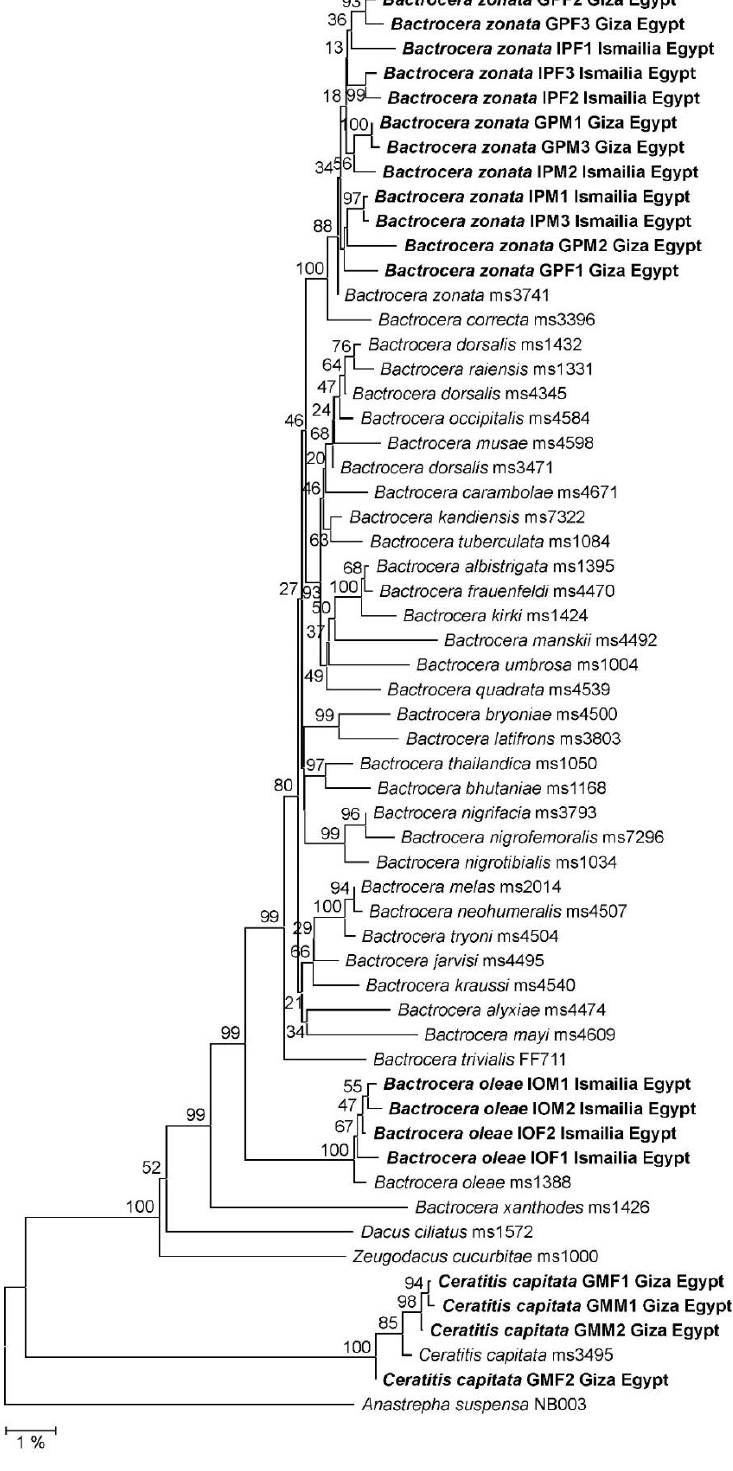
Figure 4. Neighbor Joining (NJ) phylogeny of fruit flies of the genus Bactrocera as reconstructed from a concatenation of genes CAD1, EF1A, and PERIOD. Terminal branches are labelled by genus, species, specimen, and geographic origin designations (for sequences from this study). Sequences from the present study are displayed in bold type. Numbers on internal branches indicate bootstrap support percentages. The size bar designates a branch length corresponding to 1% sequence divergence. The concatenation of orthologous sequences from the Caribbean fruit fly, Anastrepha suspensa , was used as outgroup.